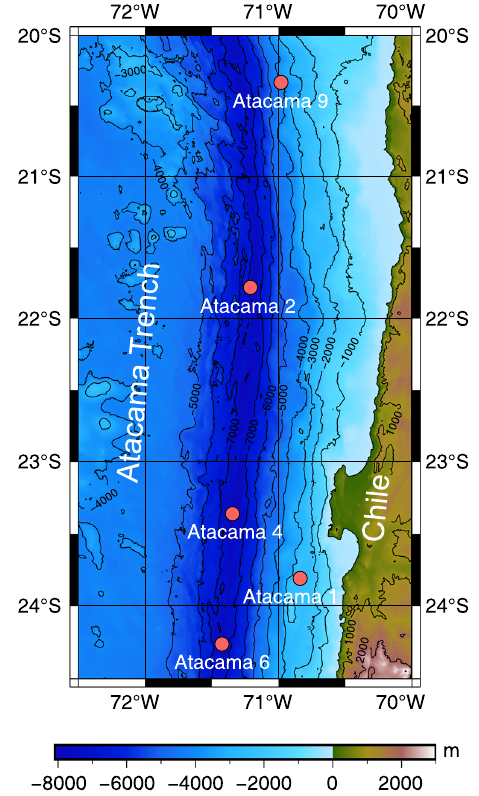
Fig. 1 | Map of the Atacama trench area with sampling sites indicated. The latitudinaldistancebetween 20°S and 24.5°S is 500km. The mapis drawn with the GEBCO_2022 Grid dataset 48